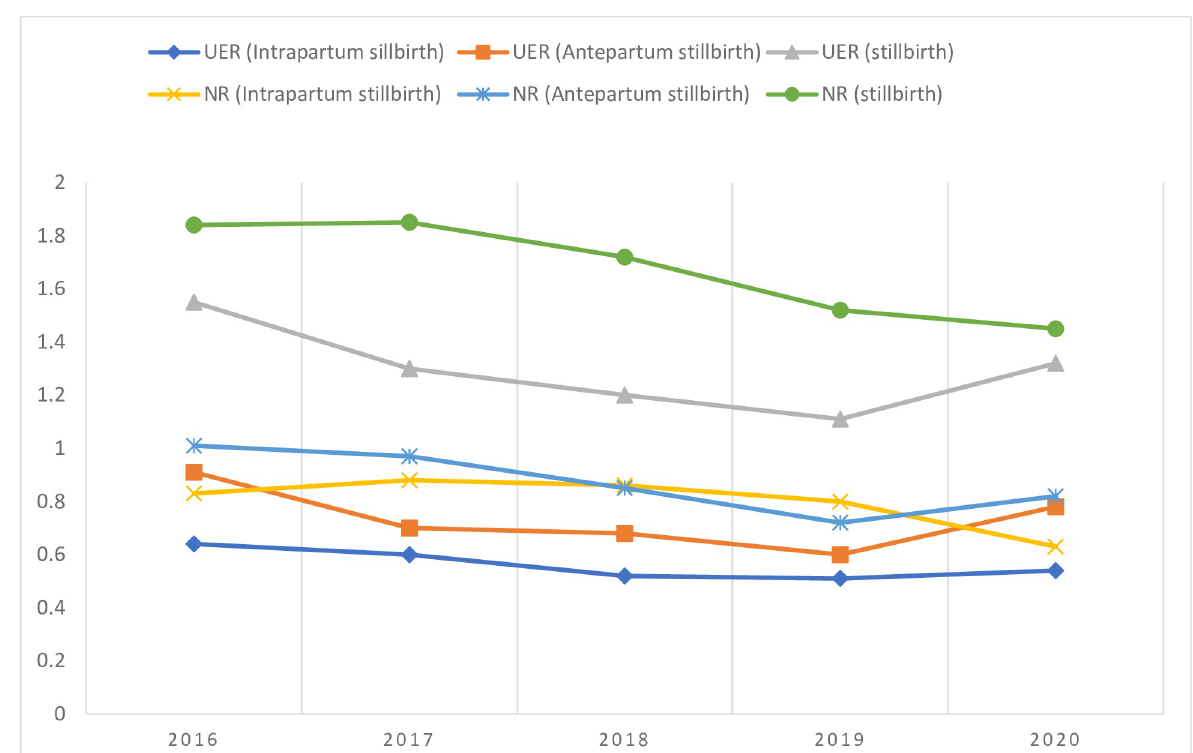
Fig 3. Stillbirth and facility delivery output of the Upper East and Northern regions of Ghana.